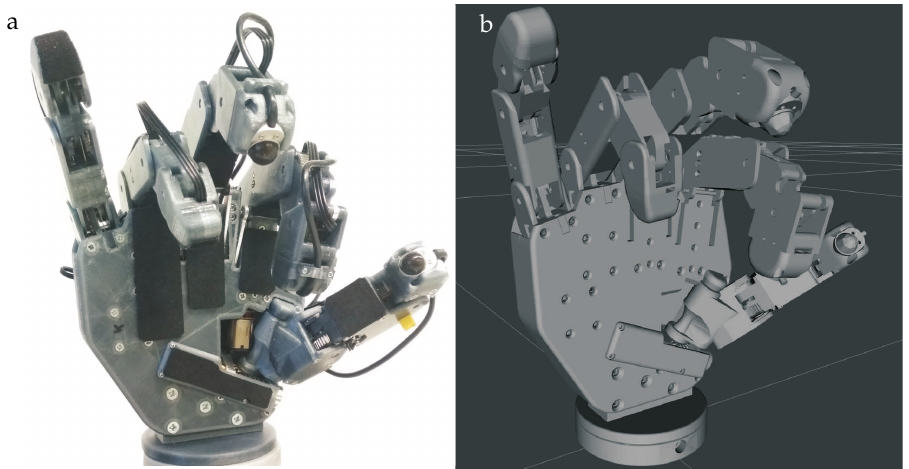
Figure 14. Sample configuration of the PUT-Hand ( a ) visualised in the RViz ( b